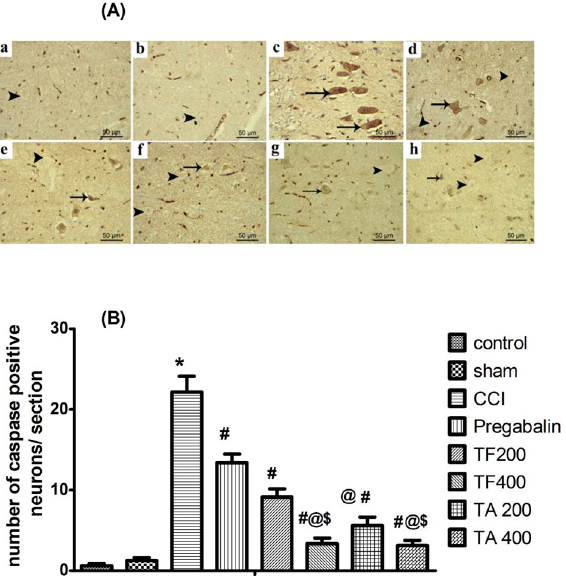
Figure 9. ( A ) Representative images showing the expression of the apoptotic neurons in different experimental groups through caspase- 3 immunostaining of brain stem sections (a) control group; (b) sham group; (c) CCI group; (d) pregabalin group; (e) TF (p.o., 200 mg/kg); (f) TF (p.o., 400 mg/kg). (g) TA (p.o., 200 mg/ kg); (h) TA (p.o., 400 mg/kg). Arrow indicating dark brown staining of the cytoplasm of immunopositive neurons and arrowhead indicating the negative immunostaining neurons. Scale bar; 50 μm. ( B ) Bar graph showing differences in the number of caspase positive neurons in all study groups in the brainstem areas. The immunopositive neurons were counted over the entire 6 animals/group in 3 non-overlapping fields from × 200 magnification. Statistical analysis was carried out using one-way ANOVA, followed by a post-hoc test by Tukey test. Values are shown as mean ± SEM (n = 6).*Significant difference from the sham group, p < 0.05; # Significant difference in comparison to the CCI group, p < 0.05; @ Significant difference compared to the pregabalin group, p < 0.05; $ Significant difference compared to the low dose TF group, p <